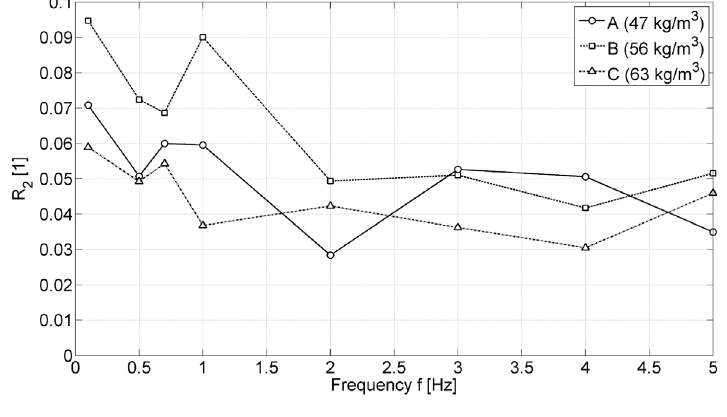
Fig. 7. Simulation error.